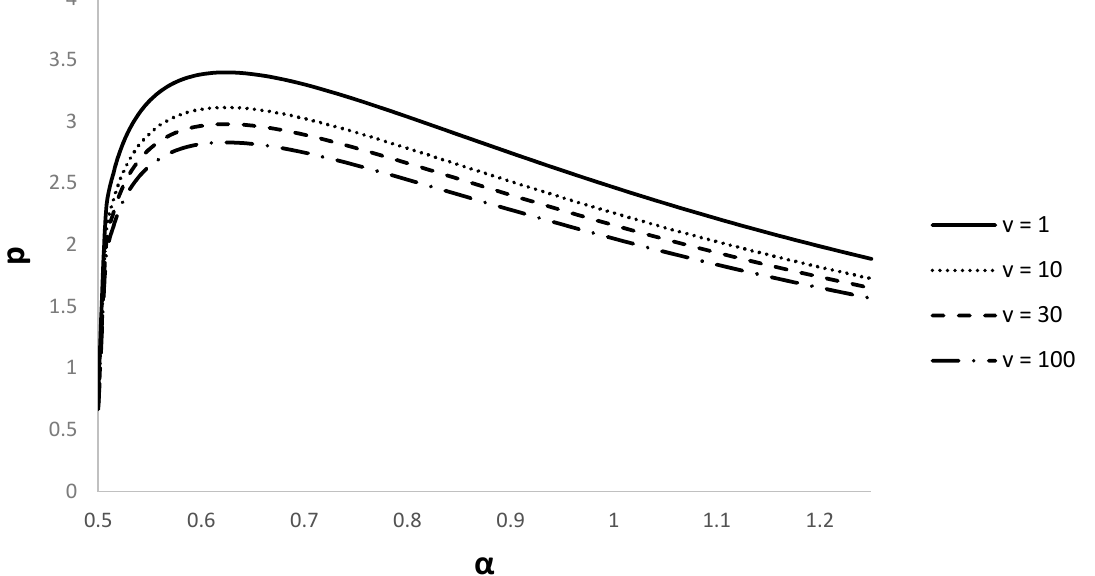
Figure 2. Variation in p with α at several values of ν .